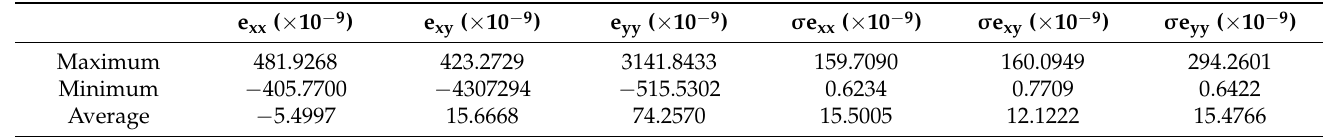
Figure 4. Maximum (MaHE) and Minimum (MiHE) Horizontal Extension in the broader Strymon area: ( a ) MaHE (blue arrows) and MiHE (red arrows) parameters vectors; ( b ) MaHE values grid, based on the interpolation (kriging) geostatistical methodology; ( c ) MiHE values grid, based on the interpolation (kriging) geostatistical methodology. Table 2. The e xx , e xy , e yy (maximum, minimum, and average) values and the corresponding uncer- tainties of the 216